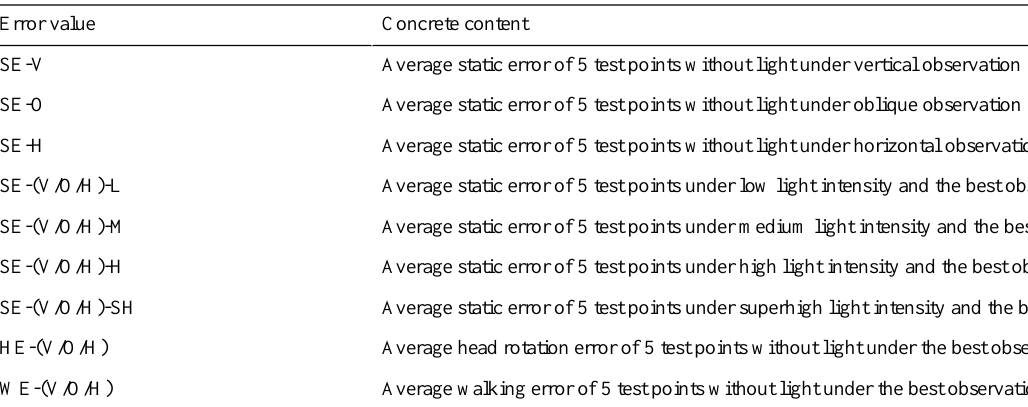
Table 1. Detailed content of the performance